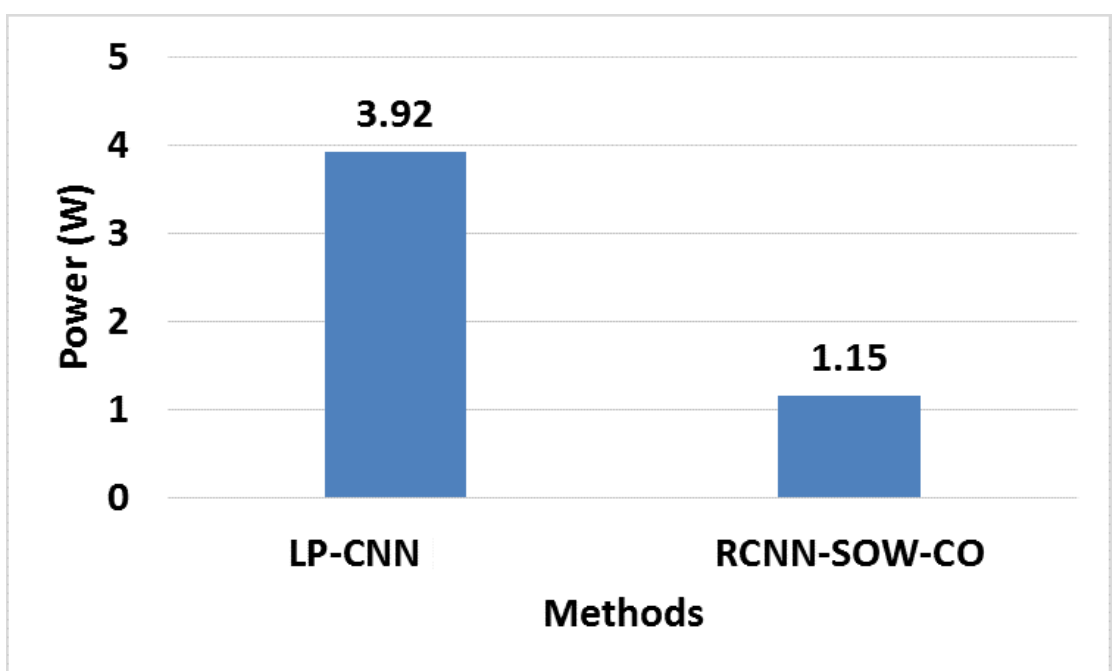
Figure 22. Comparison of power for Virtex-7. LP-CNN